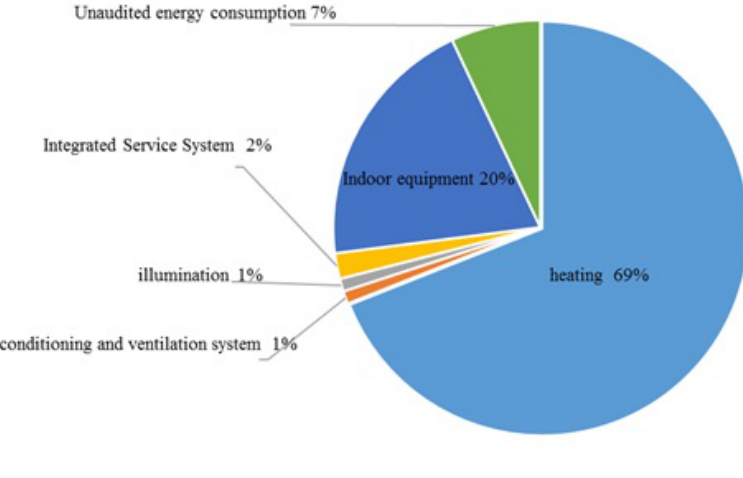
Fig. 3 Energy consumption component structure scale. Note : The National Bureau of Statistics of 0.404 kg of standard coal per kilowatt-hour is used as the coefficient of power